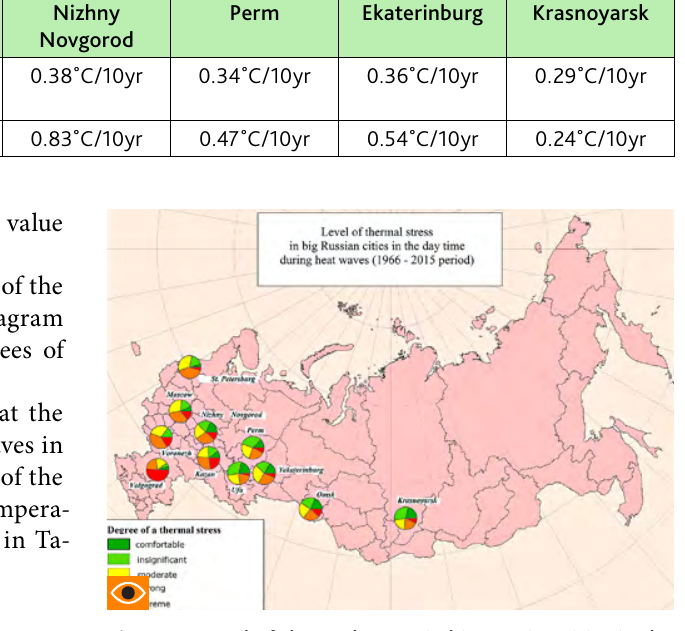
Figure 3. Level of thermal stress in big Russian cities in the